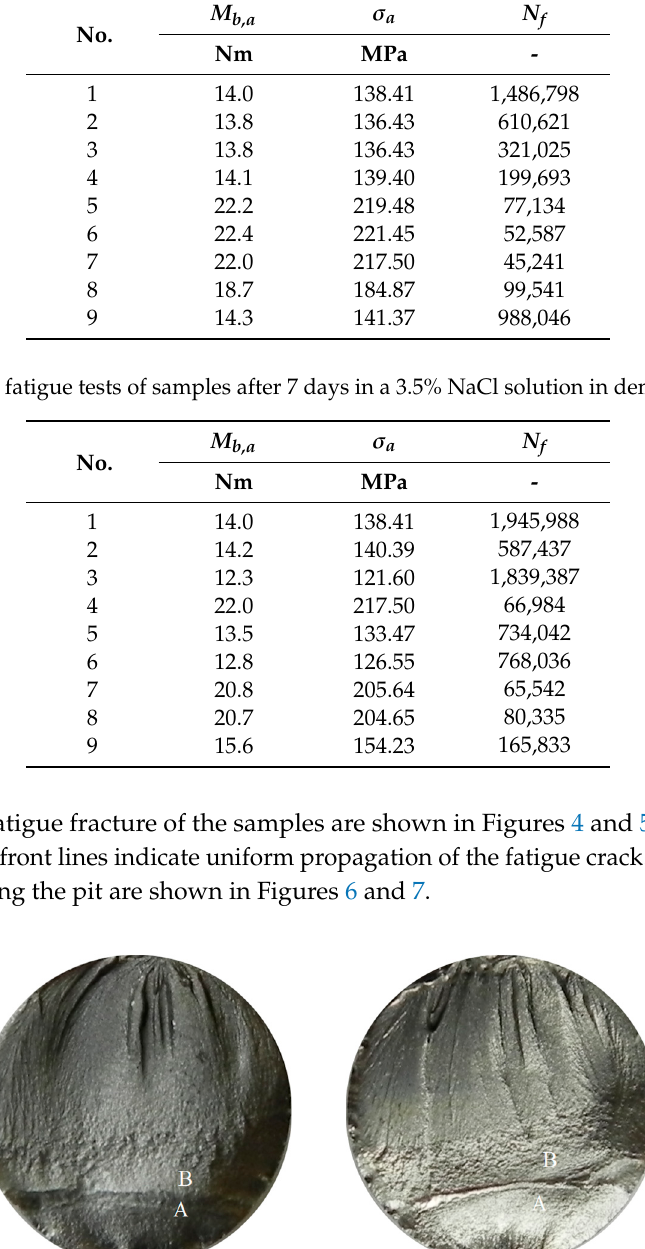
Table 7. Results of fatigue tests on samples after 14 days in a 3.5% NaCl solution in demineralised water.